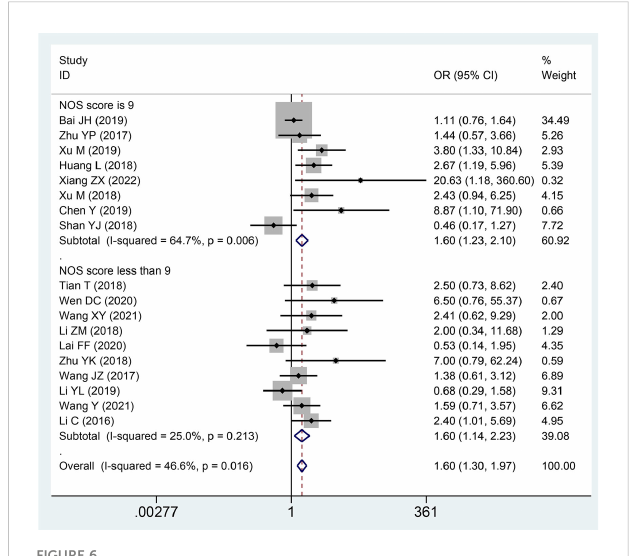
FIGURE 6 Forest plot showing the relationship between small nucleolar RNA host gene (SNHG) expression and distant metastasis (DM) stage in colorectal cancers.